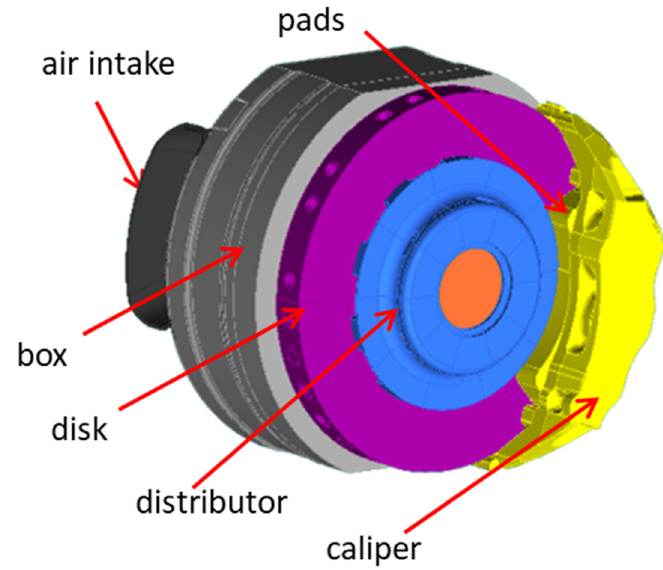
Figure 1. Component assembly of the disk brake system.